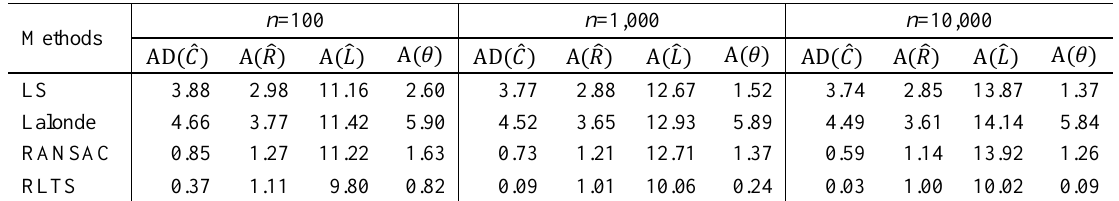
Table 2. Evaluation of estimated parameters for cylinders of different number of points